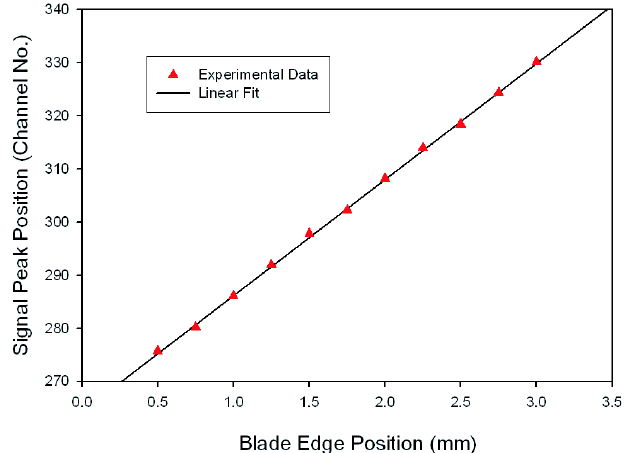
FIG. 5. (Color) Plot of the ODR signal peak vertical position versus the distance from the beam to blade edge. Since the beam vertical position did not change on this scale as monitored by the rf BPM, the ODR signal peak is coming from near the metal screen edge.